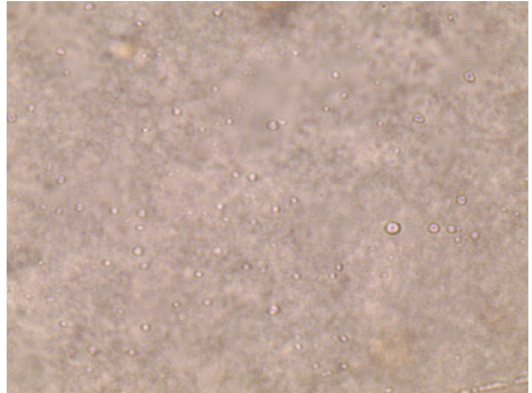
Figure 9. A representative light microscopy picture of levosulpiride niosomal